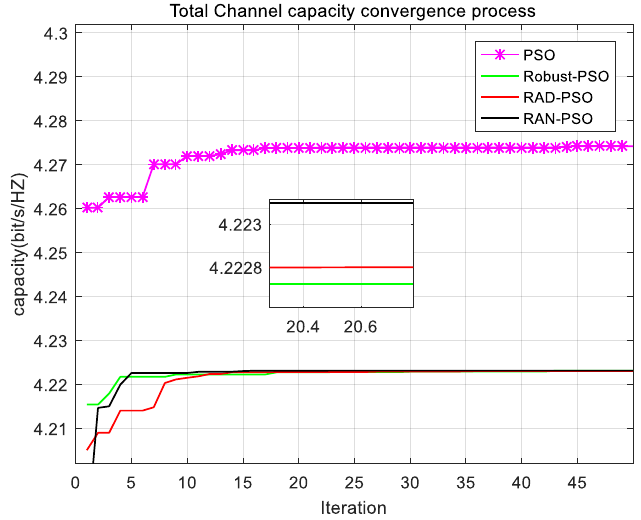
Figure 2. Convergence process of total channel capacity of cognitive users.